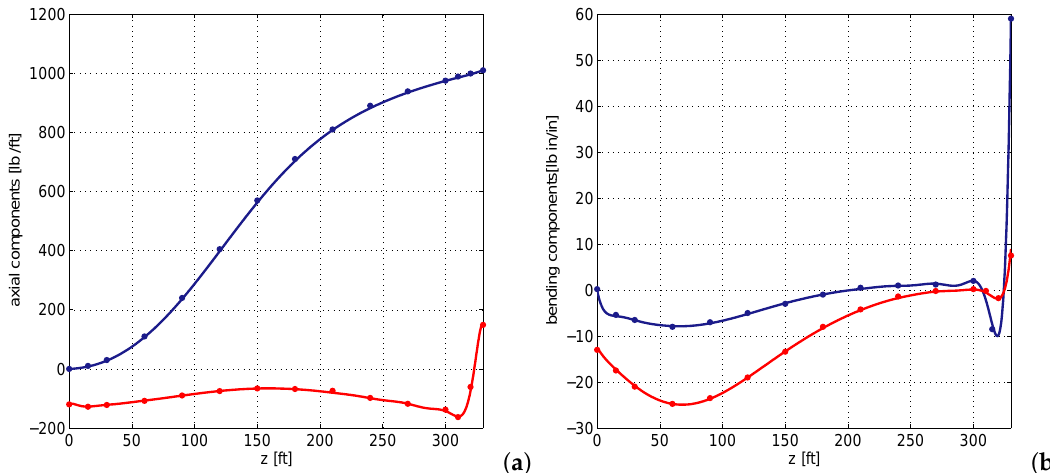
Figure 14. Hyperboloid of revolution under wind load. ( a ) Membrane stress resultant N 11 : blue solid line—present approach vs. blue bullets—reference results [58]; membrane stress resultant N 22 : red solid line - present approach vs. red bullets—reference results [58]. ( b ) Bending moment M 11 : blue solid line—present approach vs. blue bullets—reference results [59]; bending moment M 22 : red solid line - present approach vs. red bullets—reference results [59].